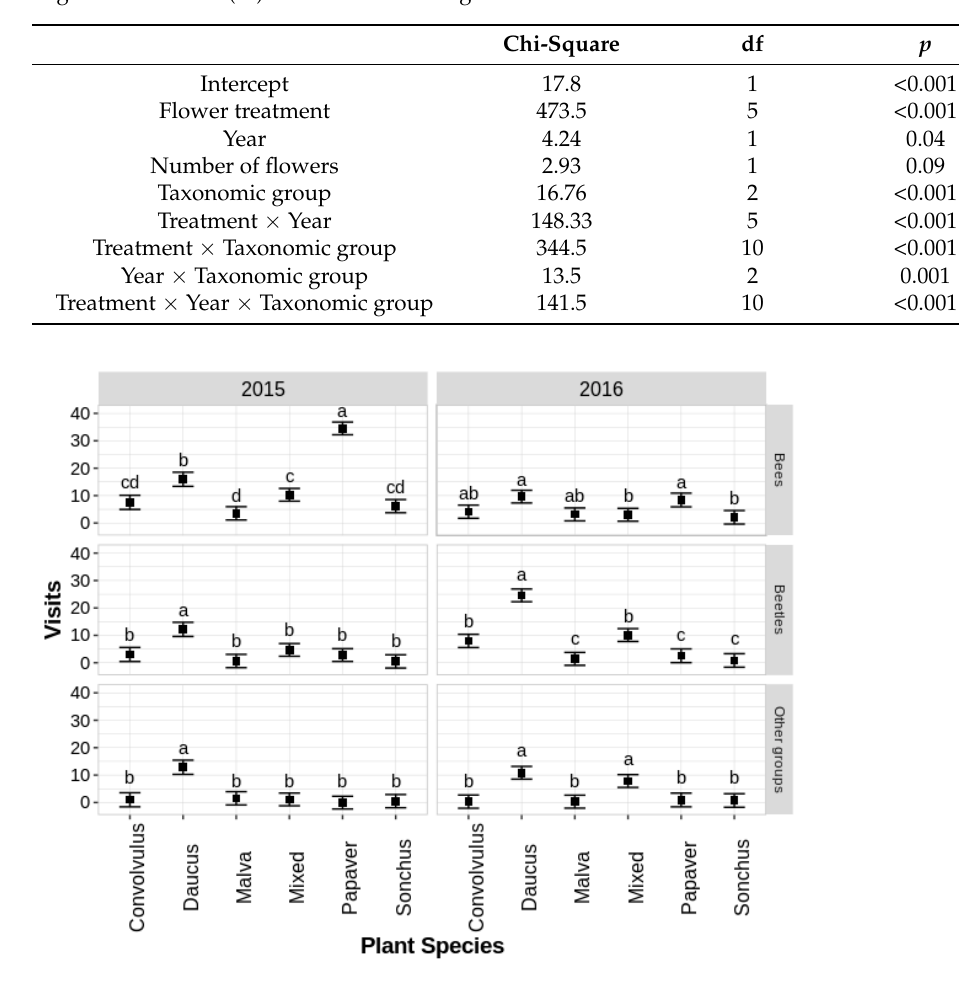
Figure 5. Differences in the average number of visits from bees, beetles, and other insect groups to the flower treatments in both years of the study (2015 and 2016). Values are the estimated marginal means from the general mixed-effects model accounting for the number of flowers in the plots. Bars show confidence intervals at the 0.95 level. Letters indicate differences between treatments for a given year and insect taxonomic group derived from post hoc pairwise comparisons using the Tukey method for p -value adjustment (at p < 0.05). Flower species are indicated by genus.